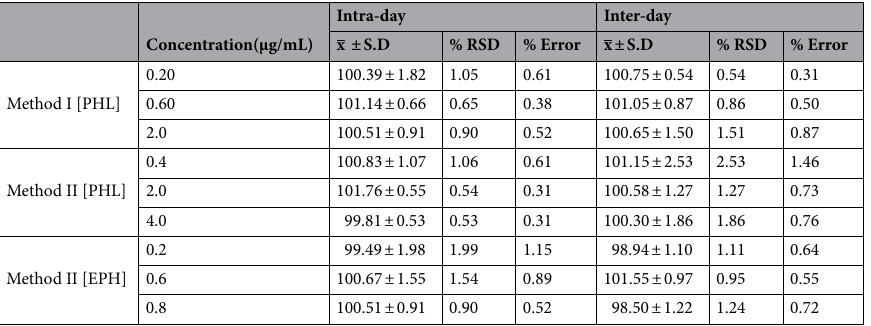
Table 3. Precision data of pholcodine and ephedrine using the proposed spectrofluorimetric methods.